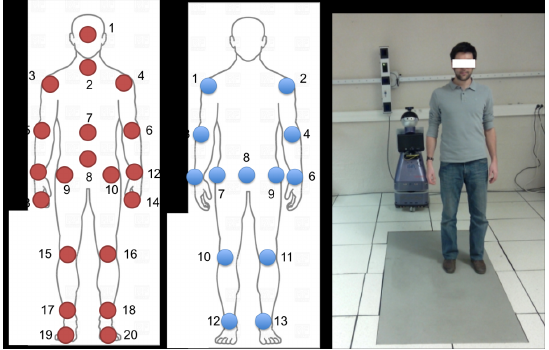
Figure 10. The anatomical joints detected by the Microsoft Kinect SDK algo- rithm (left), the CodaMotion markers placement on the subjects’ bodies (center) and the experimental setting (right).